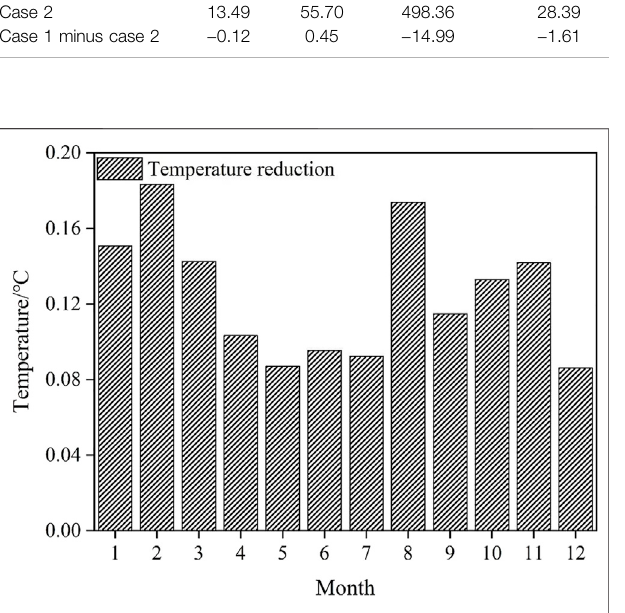
FIGURE 3 | Reduction of simulated temperature caused by the DRE in each month of 2021.